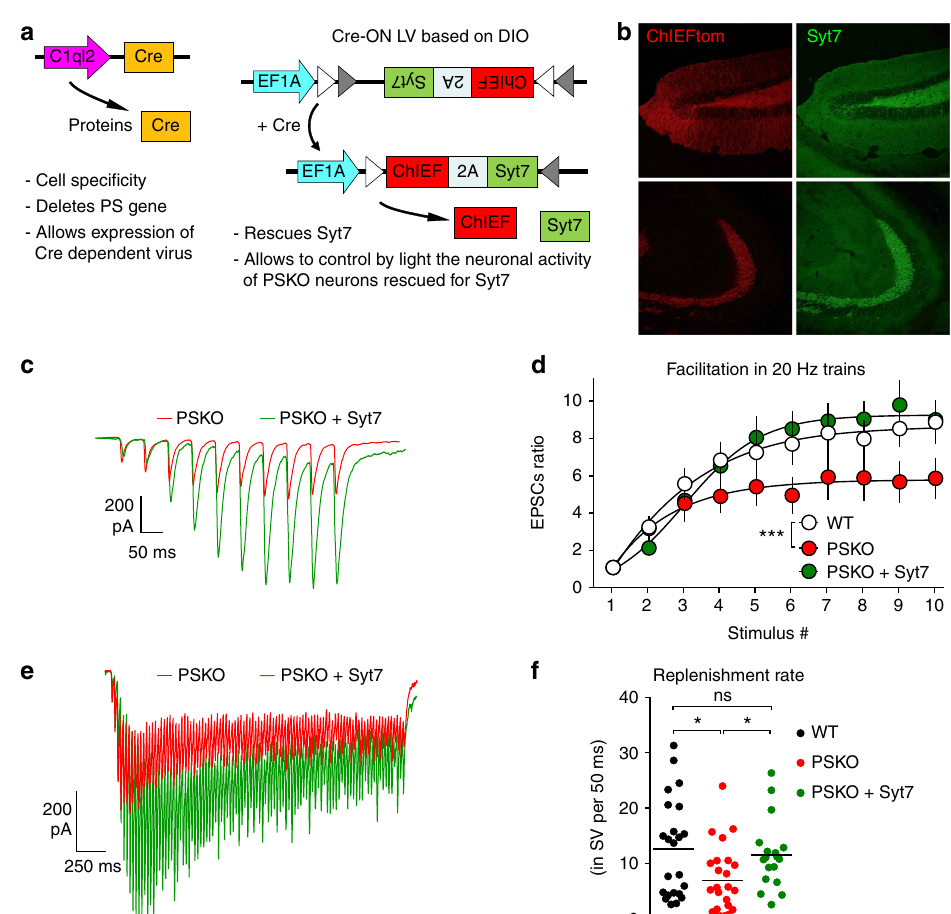
Fig. 4 Impaired facilitation and SV replenishment in PSKO Mfs is caused by decreased Syt7 expression. a Schemes of the two lentiviruses (LV) used to rescue Syt7 expression in PSKO GCs controlled by light. C1ql2 promoter restricts the expression of Cre to GCs where the fl oxed PS gene is deleted. The Cre also allows the Cre-ON LV to express Syt7 and ChIEF. b Confocal images showing the rescued expression of Syt7 in the hilus (up) and in the stratum lucidum (down) using the strategy described in a . c Representative traces of EPSCs evoked by 10 repetitive light pulses at 20 Hz. d Analysis of presynaptic facilitation in 20 Hz trains. Facilitation is represented by the amplitude of the EPSCs normalized to the amplitude of the fi rst EPSC. Facilitation, impaired in absence of presynaptic PS, recovers to WT level by re-expression of Syt7. (Two-way ANOVA, n = 24 in WT, 23 in PSKO, 24 in PSKO + Syt7, p = 0.001). Errors bars represent s.e.m.) e Representative EPSCs evoked by 100 stimuli at 40 Hz. The amplitude of EPSCs is rescued by Syt7 re-expression. f Scatter plots with means of replenishment rates calculated per neuron are represented by genotype. The replenishment rate impaired by the absence of PS is rescued by re-expression of with a γ -secretase inhibitor (GSI: L685,458 at 10 µM) for 4 days (from 10 to 14 DIV) and preparing protein lysates for western- blot (WB) analysis. The Syt7 antibody labelled two bands at 46 and 80 kDa (Fig. 5a), as in the microdissected brain samples.